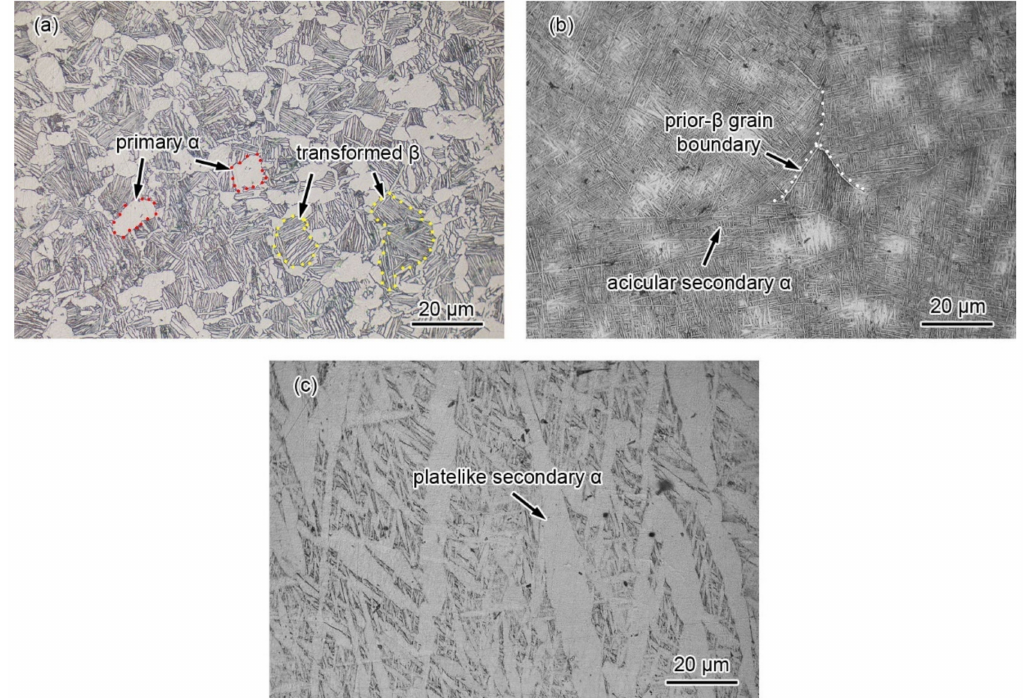
Figure 2. Microstructure of the base material ( a ), heat–affected zone ( b ), and weld material ( c ) of the